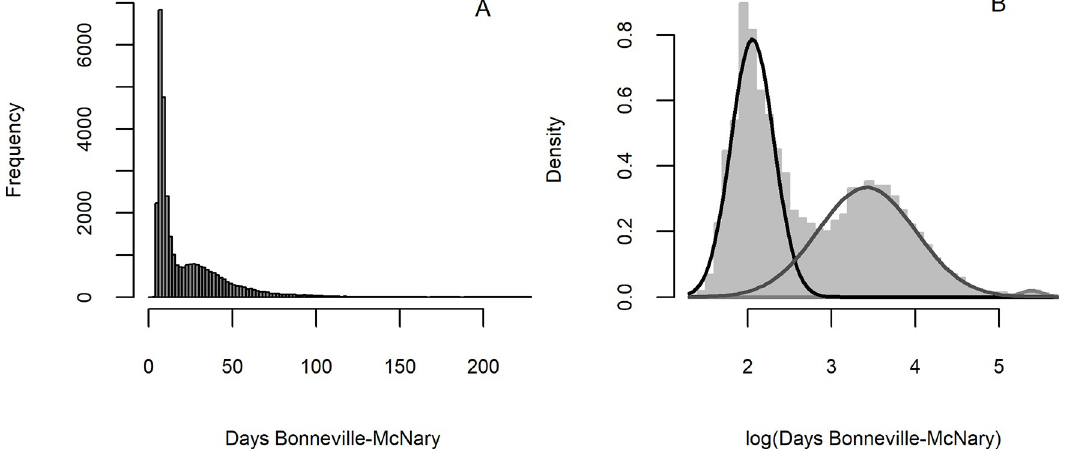
Fig 2. Travel time distribution. Histogram of mid-Columbia travel times through the study reach from Bonneville to McNary dam (A) and log-transformed travel times fit to a tri-modal Gaussian mixture model for fast , slow , and overwintering fish (B) for entire